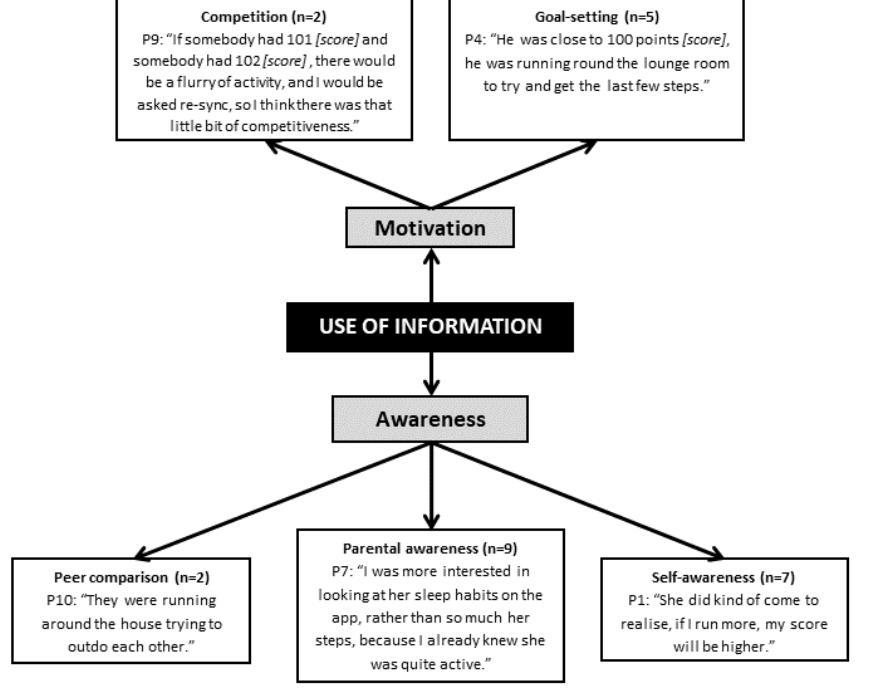
Figure 3. Use of information collected by the wearable activity tracker. P: